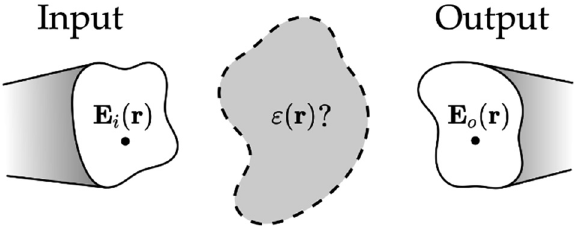
Figure 5: Optical interconnections design. The goal is the determination of geometrical and material properties of the central grey volume that r ) to output E r ) electric fields with maximal efficiency maps input E i ( o ( and minimal cross